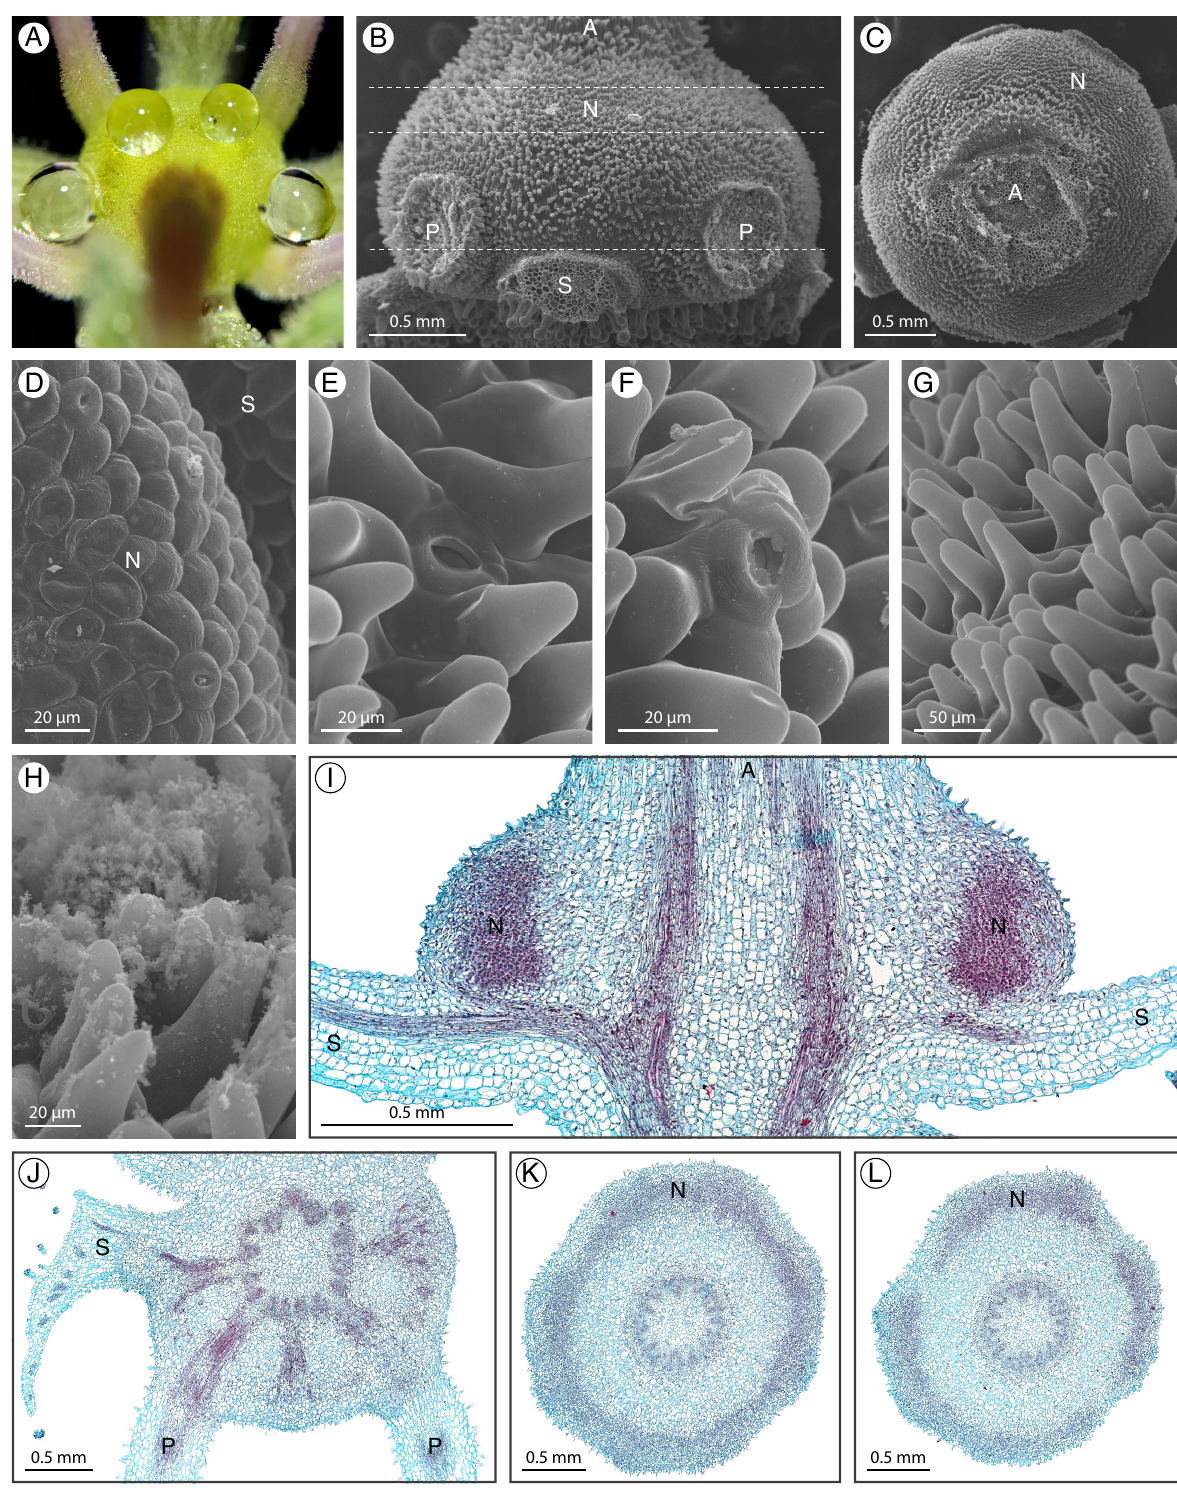
Figure 5. Gynandropsis gynandra nectary ( A ) photograph, ( B – H ) scanning electron micrographs, and ( I – L ) fast green/safranin O-stained sections. ( A ) Apical view of the nectary. ( B ) Side view of the nectary. ( C ) Apical view of the nectary. ( D ) Apical view close-up of the bud stage nectary. ( E , F ) Close- up of nectarostomata. ( G , H ) Close-up of the nectary. ( I ) Longitudinal section of the intermediate stage nectary. ( J – L ) Transverse sections of the nectary, corresponding to the dashed lines in ( B ) from proximal to distal, respectively. All images are of anthetic stage specimens unless indicated otherwise. A: androgynophore; F: filament; N: nectary; P: petal; S: